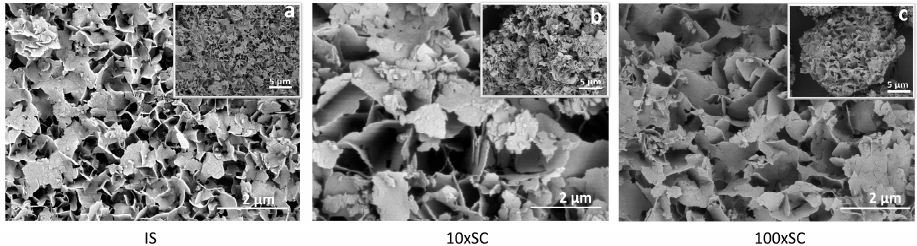
Figure 7. SEM micrographs of the final OCP phases (scale bar 5 μ m (top right) and 2 μ m (bottom right)): ( a ) initial synthesis (24 h time point), ( b ) tenfold scale ‐ up (72 h time point), and ( c ) hundredfold scale ‐ up (180 h time point).